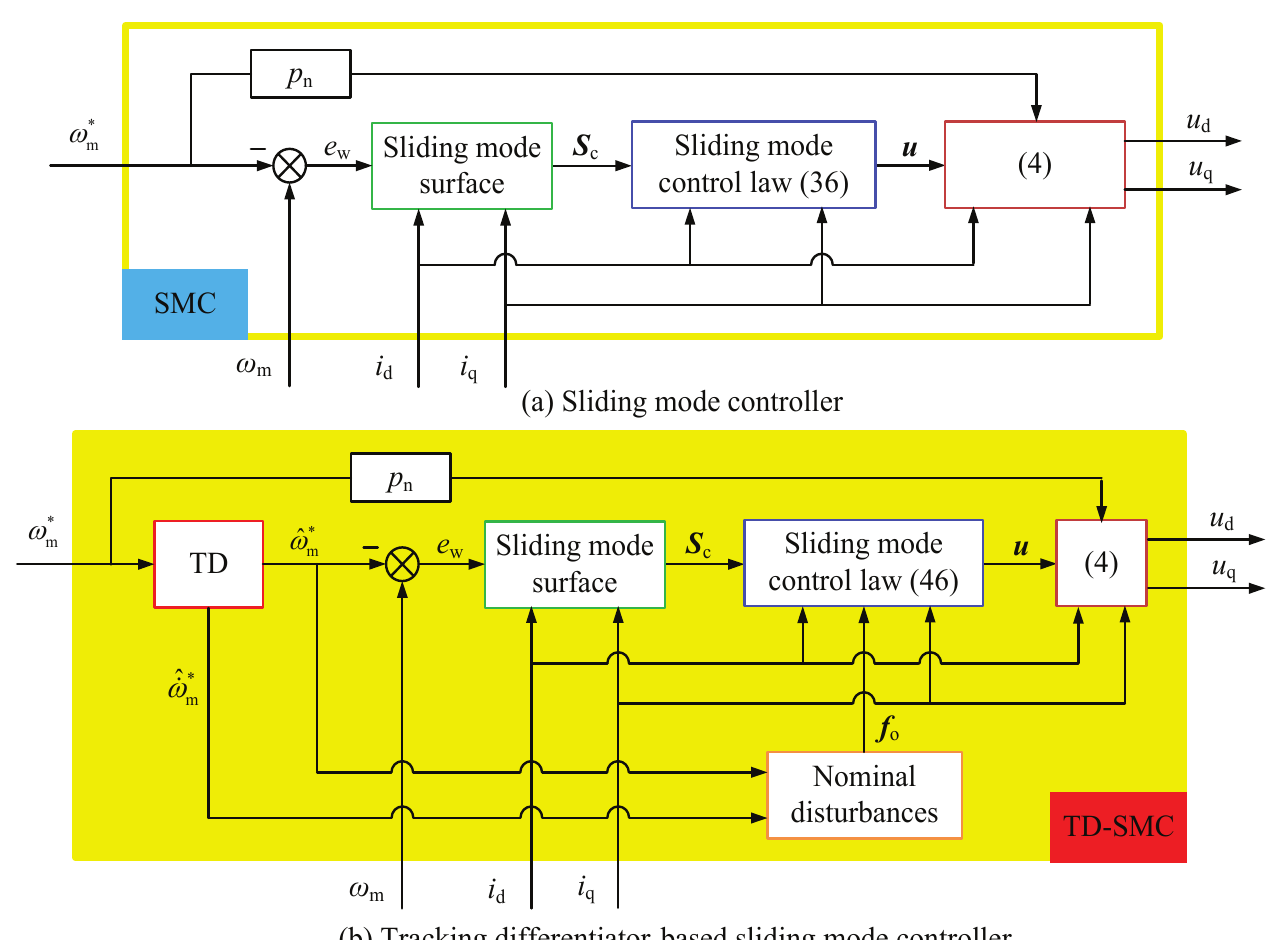
Figure 1. The schematic block diagrams of the different non-cascade SMC strategy. In the last, the whole block control structure for a PMSM servo system is shown as Figure 2. In Figure 2, a DC voltage source with U dc is firstly provided as the power supply, and then the three-phase inverter drives the PMSM based on the pulse signals. Meanwhile, the three-phase currents i A , i B and i C are individually measured by the sensors, which are transformed into the d and q axes stator currents i d and i q by the well-known Clark and Park components (where the i α and i β are intermediate current values without using the angle information). On the other hand, according to the mechnical encoder, the motor speed and electrical angle θ e will be calculated, simultaneously. Therefore, the different non-cascade control SMC strategy shown as Figure 1 can be implemented. Eventually, the controller output u d and u q will be transformed into u α and u β based on the Park inverse module, thus generating the modulating waves for the well-known space vector pulse width modulation (SVPWM) element. Finally, the close-loop control scheme for a PMSM servo system is